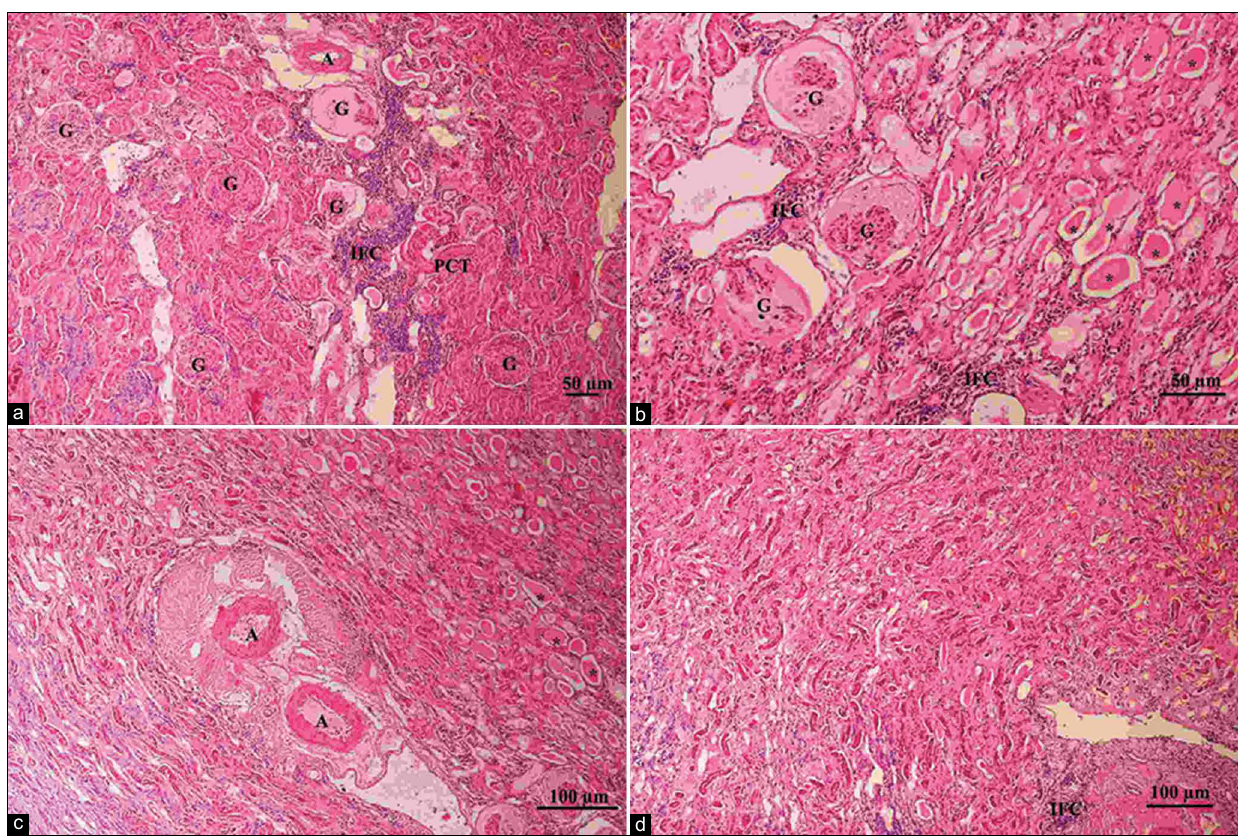
d Figure-2: Light micrographs of hematoxylin and eosin (H and E) stained the kidney sections from canine kidney with chronic kidney disease (CKD) revealed the histological structure in the renal cortex (a-c) and medulla (d). Tubules with severe degenerative changes and damaged glomeruli. The glomeruli showed sclerosis, with many inflammatory cells infiltrating (a-b and d), the arteries were thickened (c), renal tubules were dilated and filled with pink casts to show renal thyroidization (star-shaped) (b and c), and tubular atrophy and interstitial fibrosis (d) (H and E, ×200). A=Artery, G=Glomerulus, IFN=Inflammatory cells, PCT=Proximal convoluted tubule, *=Pink casts.